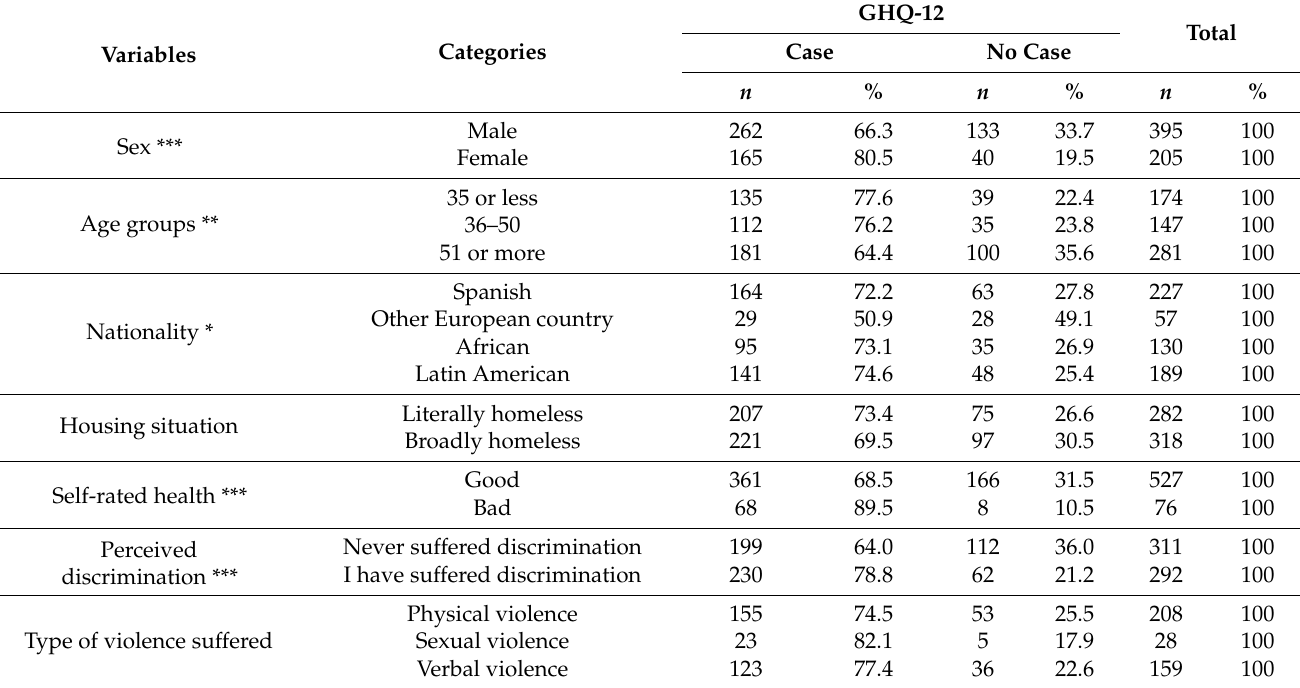
Table 3. Relations found between mental health and the independent